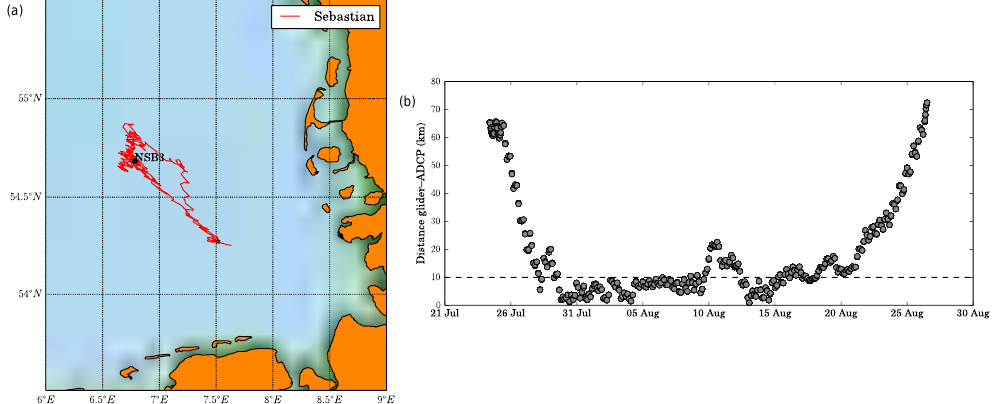
Figure 2. (a) Track of glider Sebastian during 2014 experiment and location of the bottom mounted ADCP near buoy NSB3; (b) distance between glider and bottom mounted ADCP.